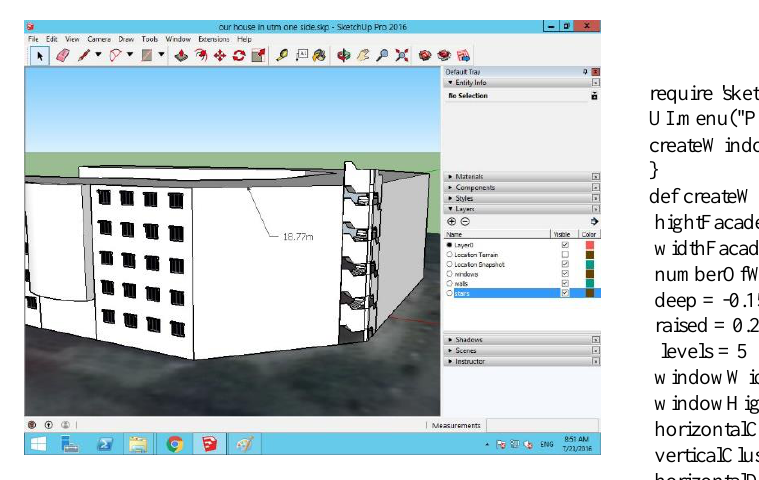
Figure 6. Parameters of DPF for automatic 3D modelling